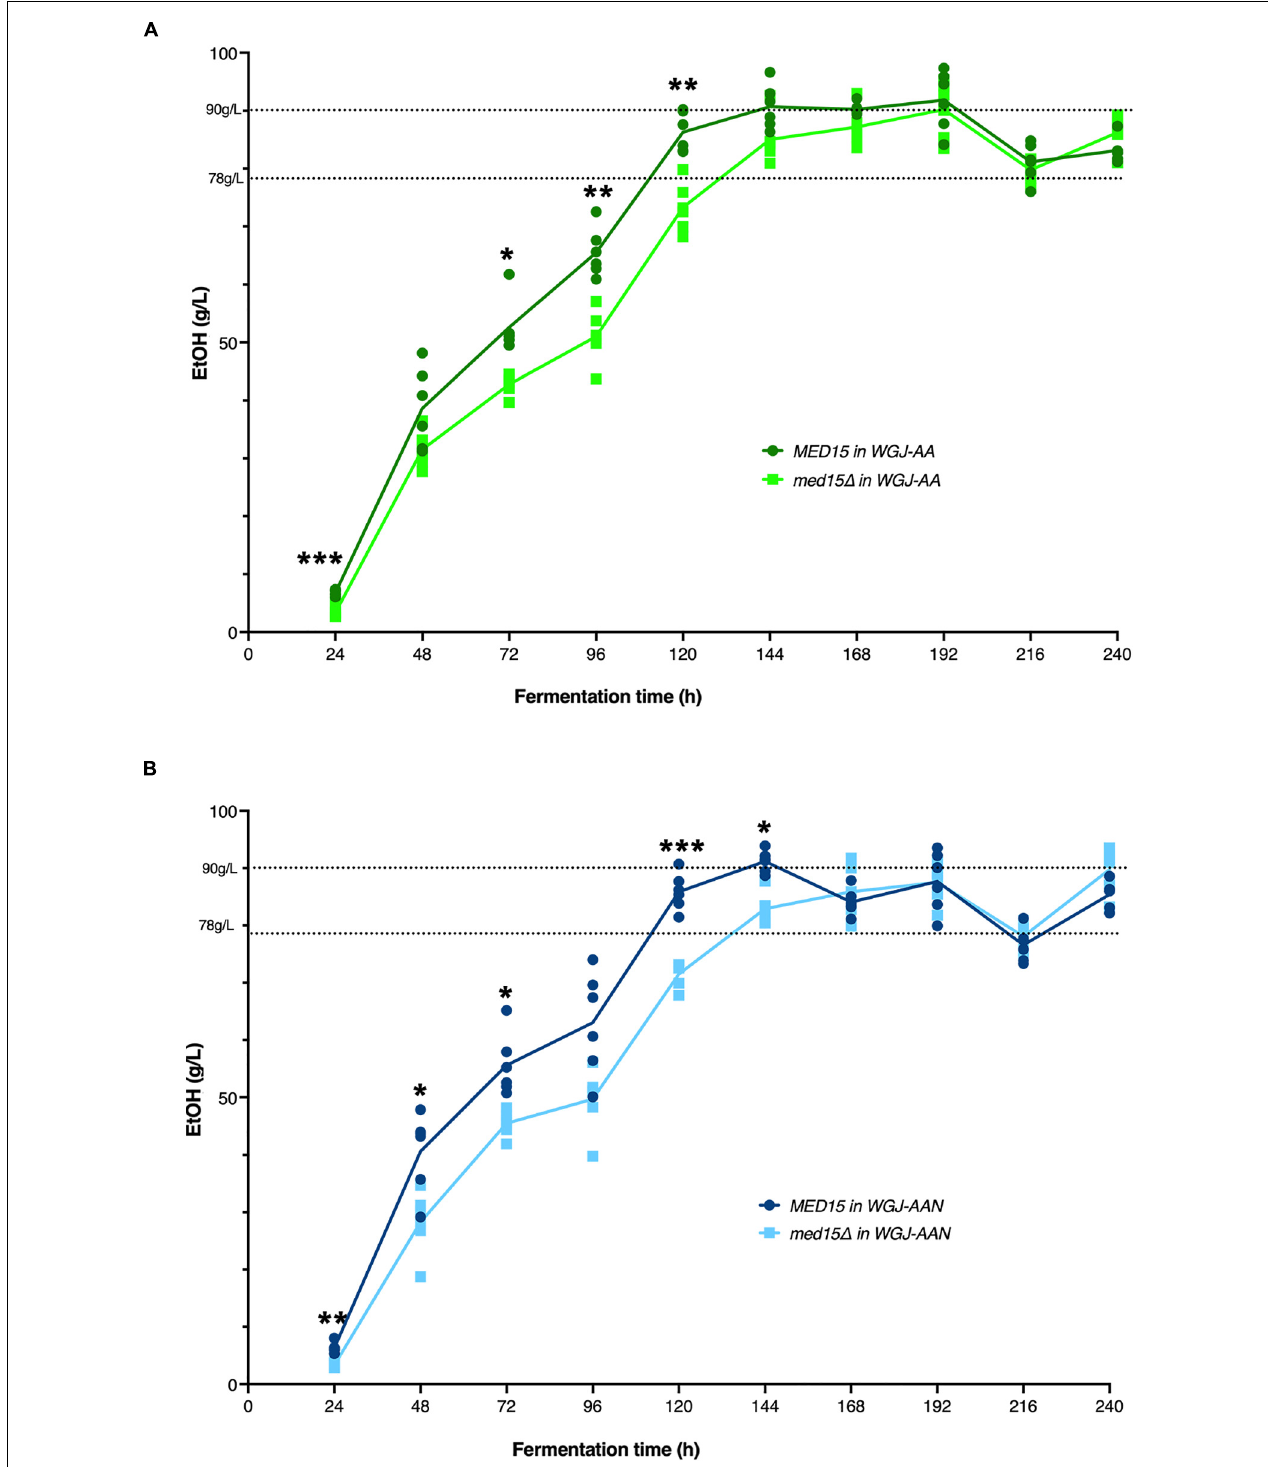
FIGURE 4 | MED15 mutants are defective in rate of ethanol production. (A) Direct measurements of ethanol production in the wild type and med15 (cid:49) strains over a 10-day fermentation time course in WGJ-AA or (B) WGJ-AA-N. Graphs show 3 biological and two technical replicates. Adjusted P values were determined with multiple two-tailed t -test and indicated as *, p ≤ 0.05; **, p ≤ 0.01; ***, p ≤ 0.001.